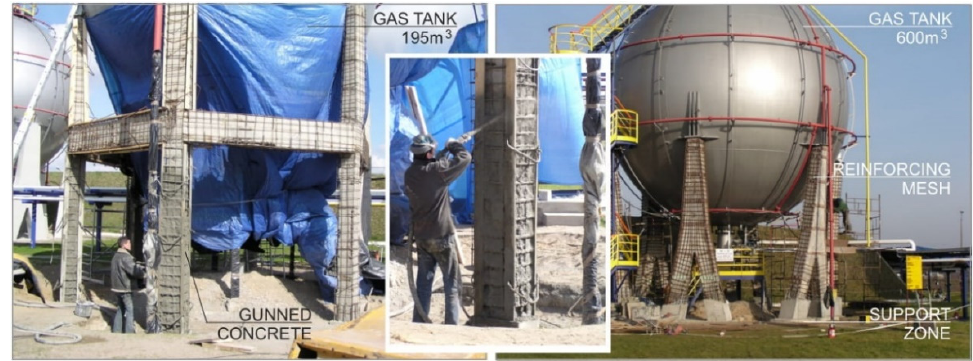
Figure 3. Details of the implemented tank-reinforcement structure.